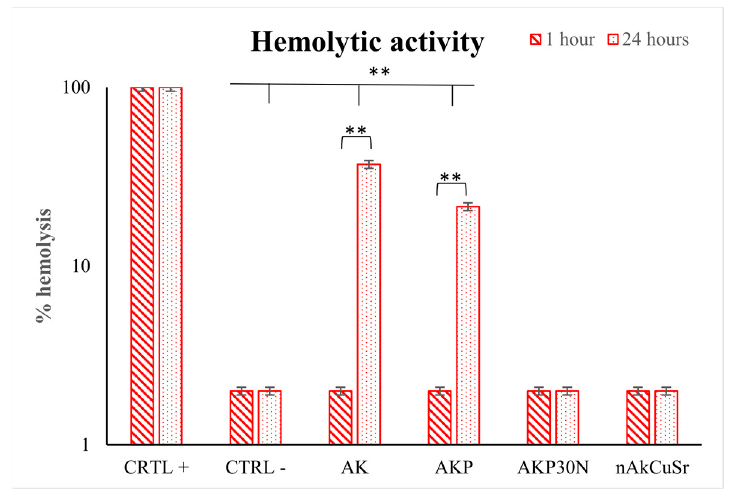
Figure 23 . Hemocompatibility of scaffolds at body temperature after 60 min and 24 h of incubation. ** indicates statistically significant differences ( p < 0.001) among negative controls and cells incubated with scaffolds, as well as between the incubation time points (1 and 24 h).